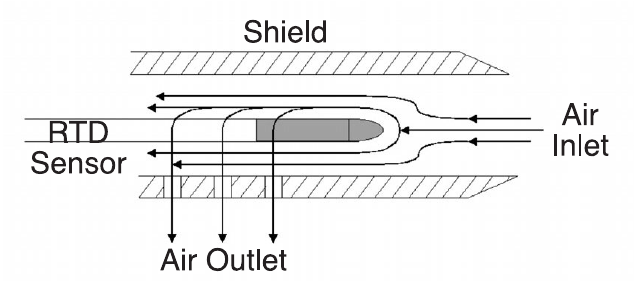
Fig. 4. Sketch of the shield protecting the RTD sensor from direct radiation.